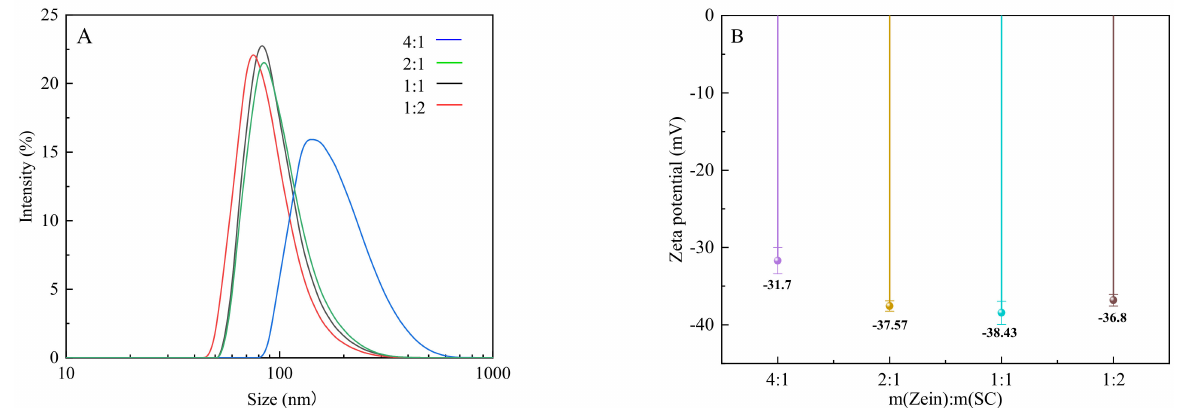
Figure 3. Particle size and zeta potential of the CA-loaded nanoparticles with different zein/SC mass ratios. ( A ) Particle-size distribution. ( B ) the average potential.